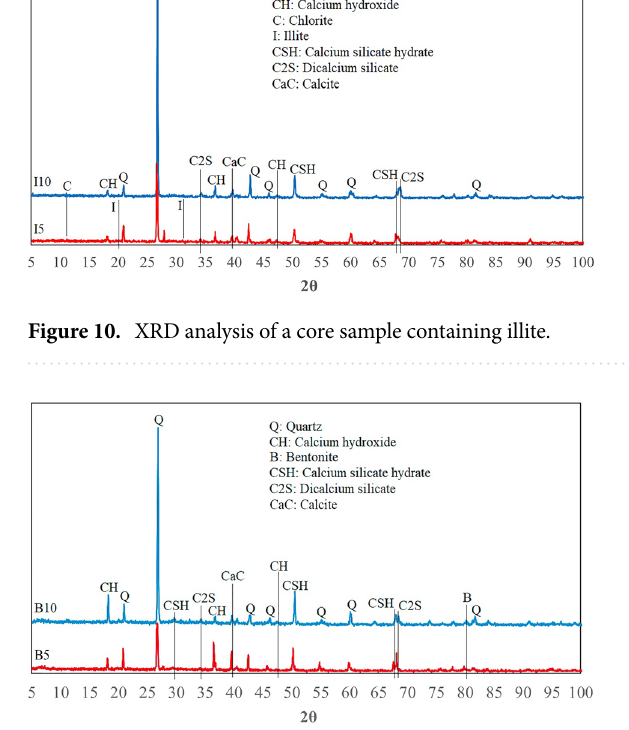
Figure 11. XRD analysis of a core sample containing